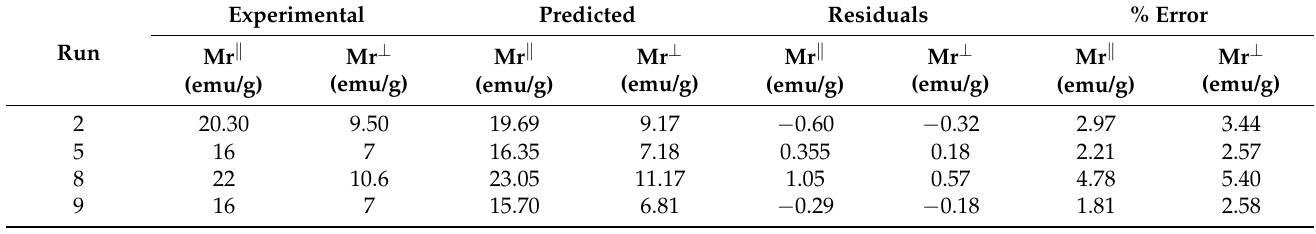
Table 12. The confirmed results for the developed model.